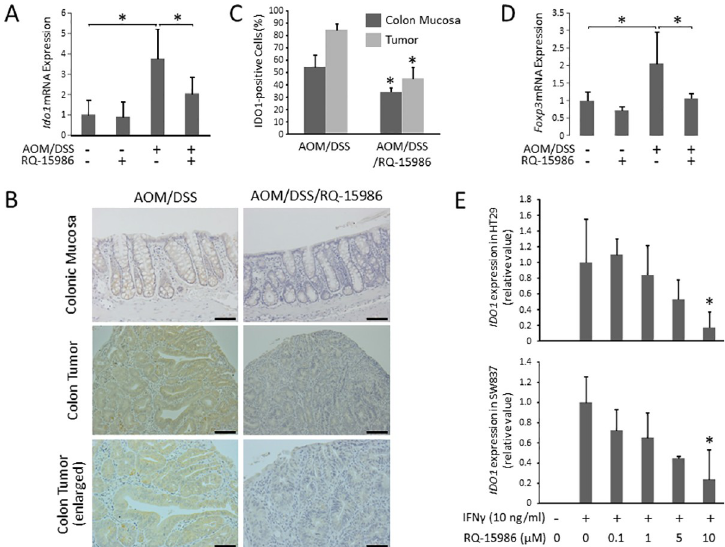
Fig 5. Effects of RQ-15986 on the levels of IDO1 in the colon of experimental rats and CRC cells. (A) Total RNA was isolated from colonic mucosa of the experimental rats, and expression levels of Ido1 mRNA were determined using quantitative real-time RT-PCR. (B) Representative images of immunohistochemical staining for IDO1 in the colonic mucosa and tumor of AOM/DSS-treated KAD rats. Scale bars, 100 μ m. (C) IDO1-positive cells were counted and the positive ratio was calculated. (D) Expression levels of Foxp3 mRNA were determined using quantitative real- time RT-PCR. Asterisk indicates statistically significant difference compared to the value in AOM/DSS group; P < 0.05. (E) HT29 and SW837 human CRC cells were pre-incubated with indicated concentration of RQ-15986 for 2 hours and then stimulated with IFN- γ (10 ng/ml) for 24 hours. Total RNA was isolated from the treated cells and expression levels of Ido1 mRNA were determined using quantitative real-time RT-PCR. Asterisk indicates statistically significant differences compared to IFN- γ -stimulated/RQ-159860-untreated group; P < 0.05. Each column represents the mean ±